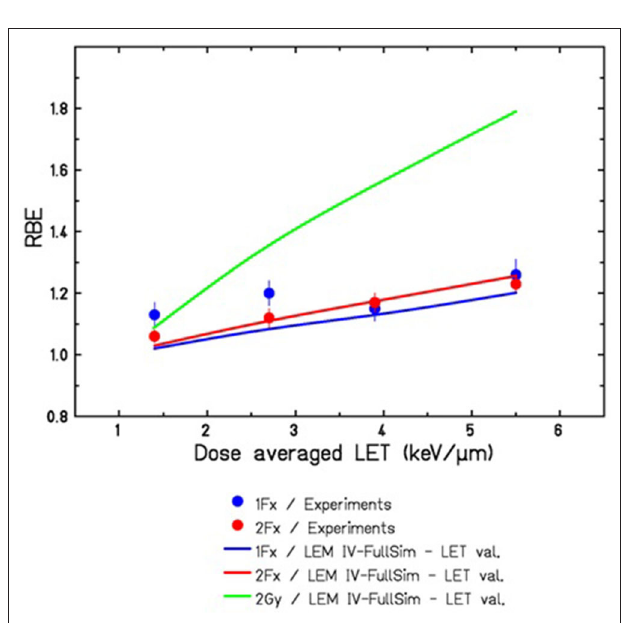
FIGURE 5 | Comparison of LEMIV based RBE predictions for tolerance doses of the rat spinal cord in a 60mm proton SOBP ranging from 70 to 130mm water-equivalent depths. Experimental data for 1Fx and 2Fx were taken from [57], corresponding to TD50 values ranging from 21.7 to 19.5Gy for 1Fx and from 32.3 to 27.9Gy for 2Fx irradiation. The full green line indicates the expected RBE for lower doses of 2 Gy/Fx, as it is typically used in the therapeutic